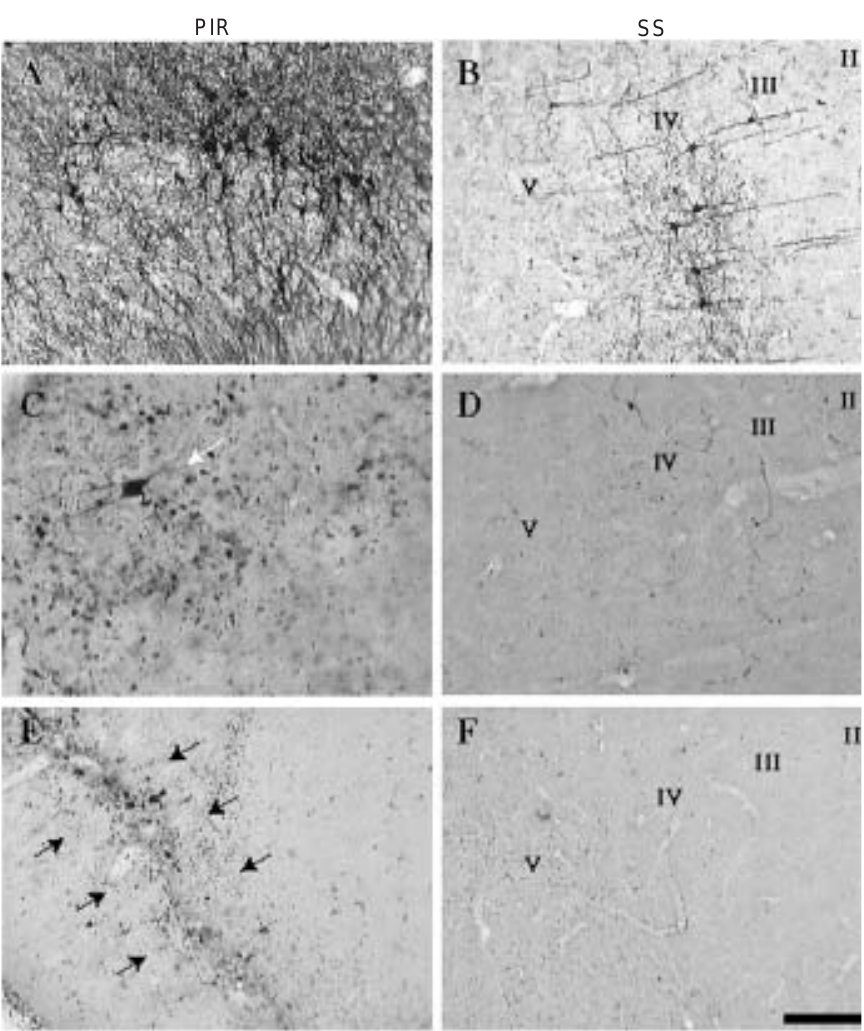
Figure 2. Bright field photomicrographs of argyrophilic cells in piriform (left panels) and somatosensory (right panels) cortical areas in three experimental situations: acute sta- tus epilepticus (SE; A and B), chronic (C and D) and SE re-induction (E and F). A , high density of silver-stained cells with their processes located mainly in piriform cortex layers II and III. C , an isolated horizontal- oriented cell in layer III (white arrow) and atrophy of layer II. E , glial scarring in piri- form cortex layer II (black arrows) possibly due to the first SE. Note in E the absence of silver-stained cells, which would indicate further damage due to the second SE. In B , high number of silver-stained cells in layers III and IV (acute SE) should be compared to the absence of injury in D and F (animals from SRS or SRS + SE groups, respective- ly). Scale bar: 120 µm.